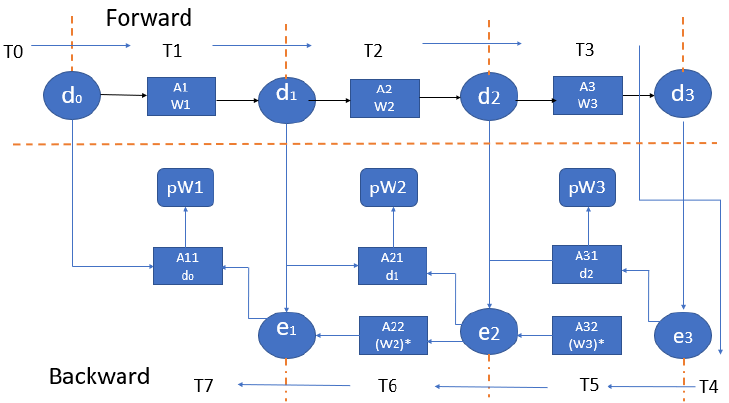
Figure 24. Pipelayer architecture to process the training phase of a neural network [26].